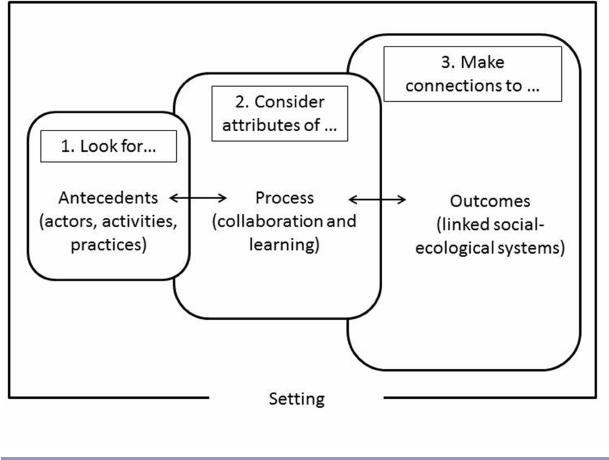
Fig. 1 . Framework for diagnosing adaptive